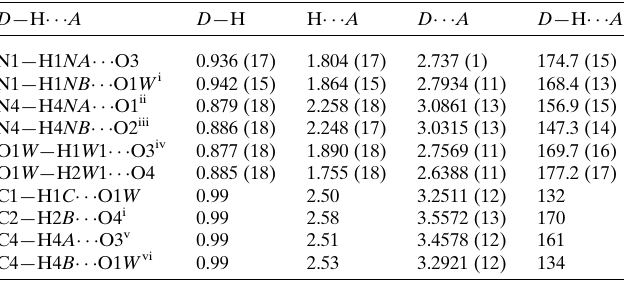
Table 2 Hydrogen-bond geometry (A˚ , (cid:4) ) for II .